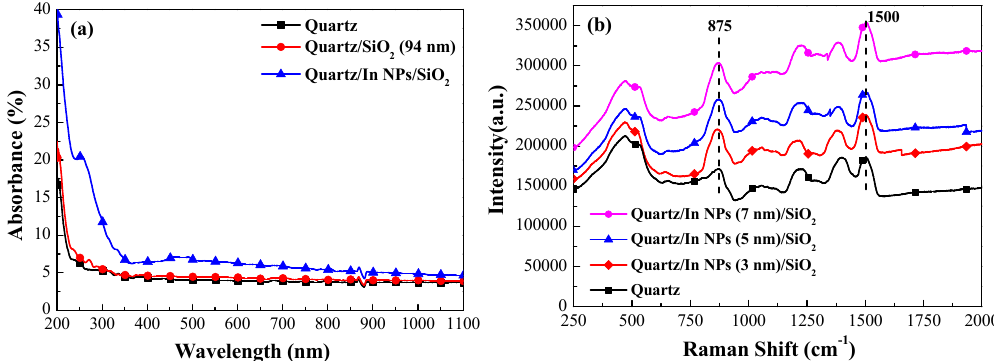
Figure 7. ( a ) Absorbance spectra of bare quartz substrate and quartz substrate coated with SiO 2 layer